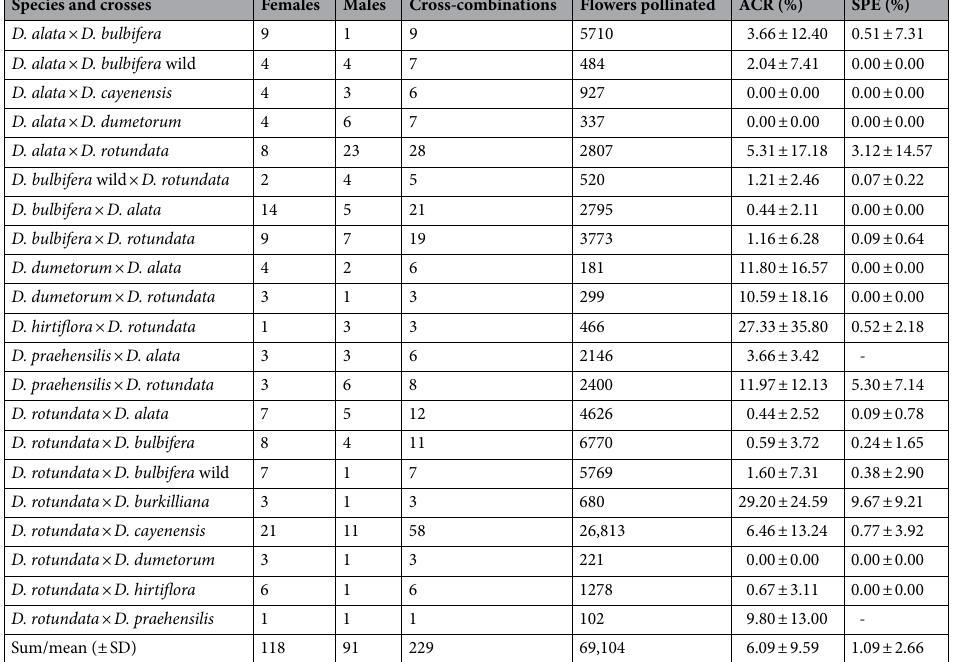
Table 2. Interspecific cross-compatibility indices among yam species ( Dioscorea spp.) The first species in the pedigree served as the female parent in the interspecific cross while the second species provided the male parents, ACR = average cross-compatibility/crossability rate, SPE = seed production efficiency. Dioscorea bulbifera wild refers to individuals of the species from the forest/wild environments. SD = standard deviation. ACR and SPE are presented by means ± standard deviation.